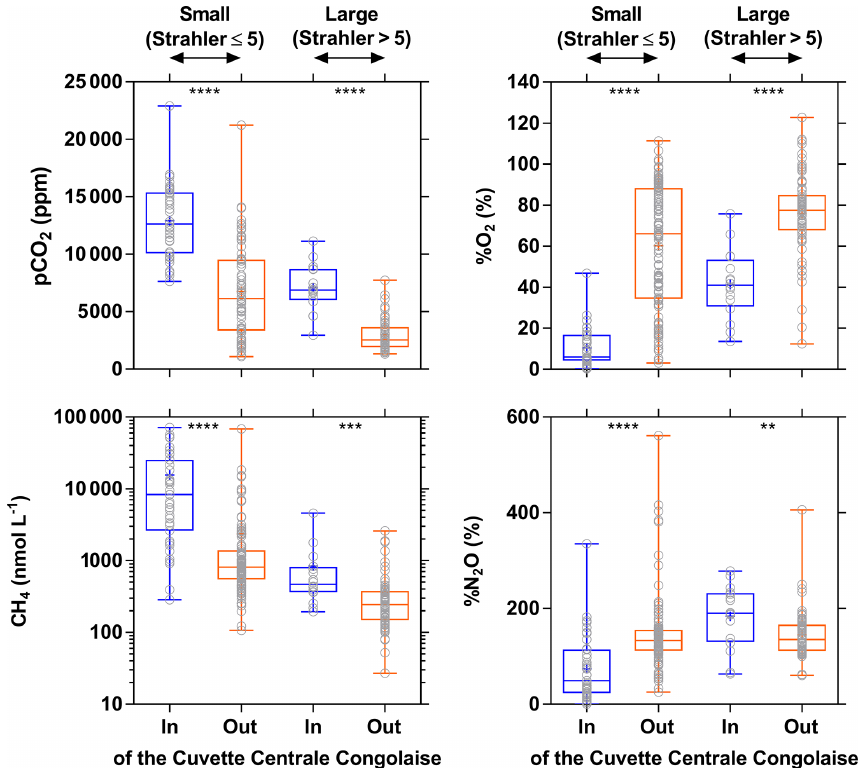
Figure 12. Box plot of the partial pressure of CO 2 ( p CO 2 in ppm), dissolved O 2 saturation level (%O 2 in %), dissolved CH 4 concen- tration (nmolL − 1 ), and dissolved N 2 O saturation level (%N 2 O in %) in surface waters of rivers and streams of the Congo river network draining and not draining the Cuvette Centrale Congolaise for small and large systems (Strahler stream order 5 ≤ and >5, respectively) (3–19 December 2013; 10–30 June 2014). The box represents the first and third quartile, the horizontal line corresponds to the median, the cross corresponds to the average, the error bars correspond to the maximum and minimum, and the symbols show all data points. A Mann–Whitney test was used to test statistical differences: ∗∗∗∗ = p< 0 . 0001; ∗∗∗ = p< 0 . 001; ∗∗ = p< 0 .